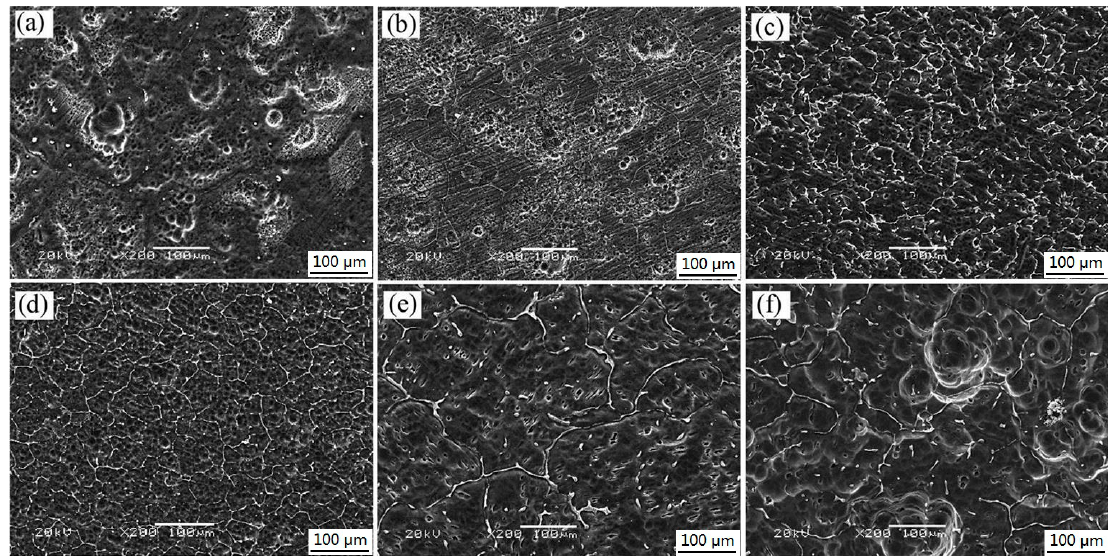
Figure 11. SEM micrographs showing the corroded Mg–2.0Zn–0.5Zr–xGd samples after immersion for 120 h and corrosion product removal: ( a ) x = 0; ( b ) x = 1; ( c ) x = 2; ( d ) x = 3; ( e ) x = 4; ( f ) x =